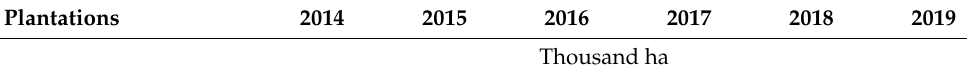
Table 4. Areas of perennial plantations in fruiting age in agriculture enterprises of Kyiv region, thous. ha.